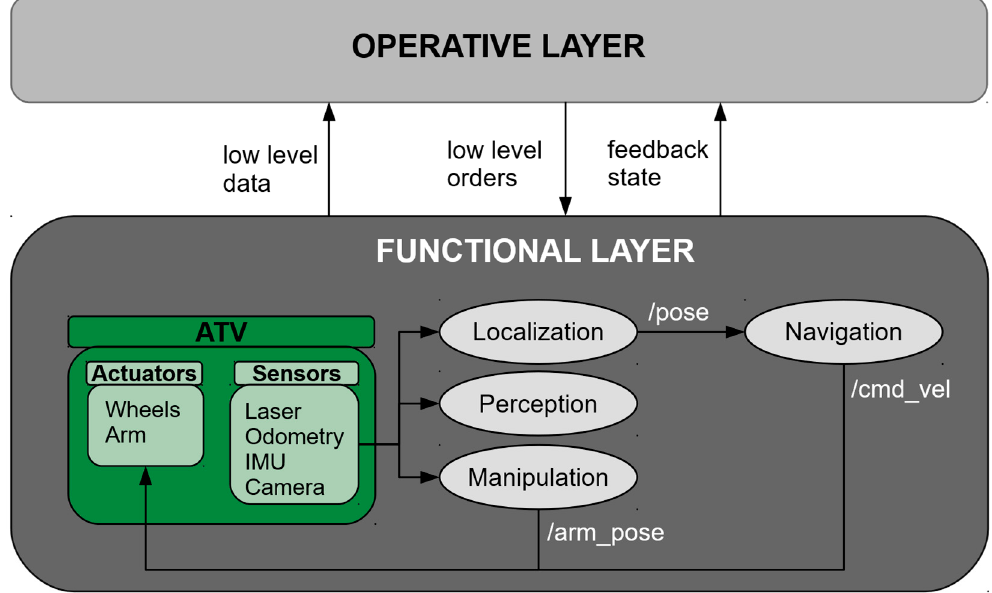
Figure 6. Functional layer.